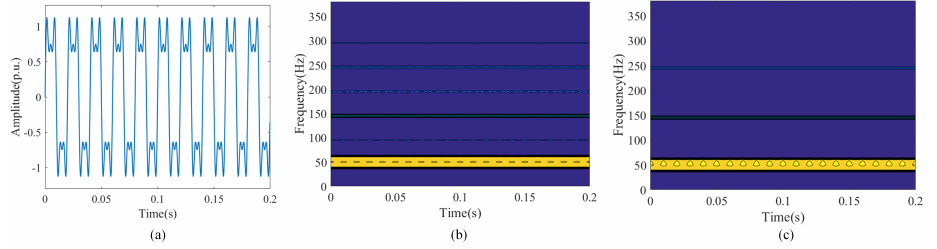
Figure 1. Comparison result on harmonic disturbance with different parameter β 1,2 . ( a ) input signal, ( b ) β 1 = 150, β 2 = 40, ( c ) β 1 = 121, β 2 =